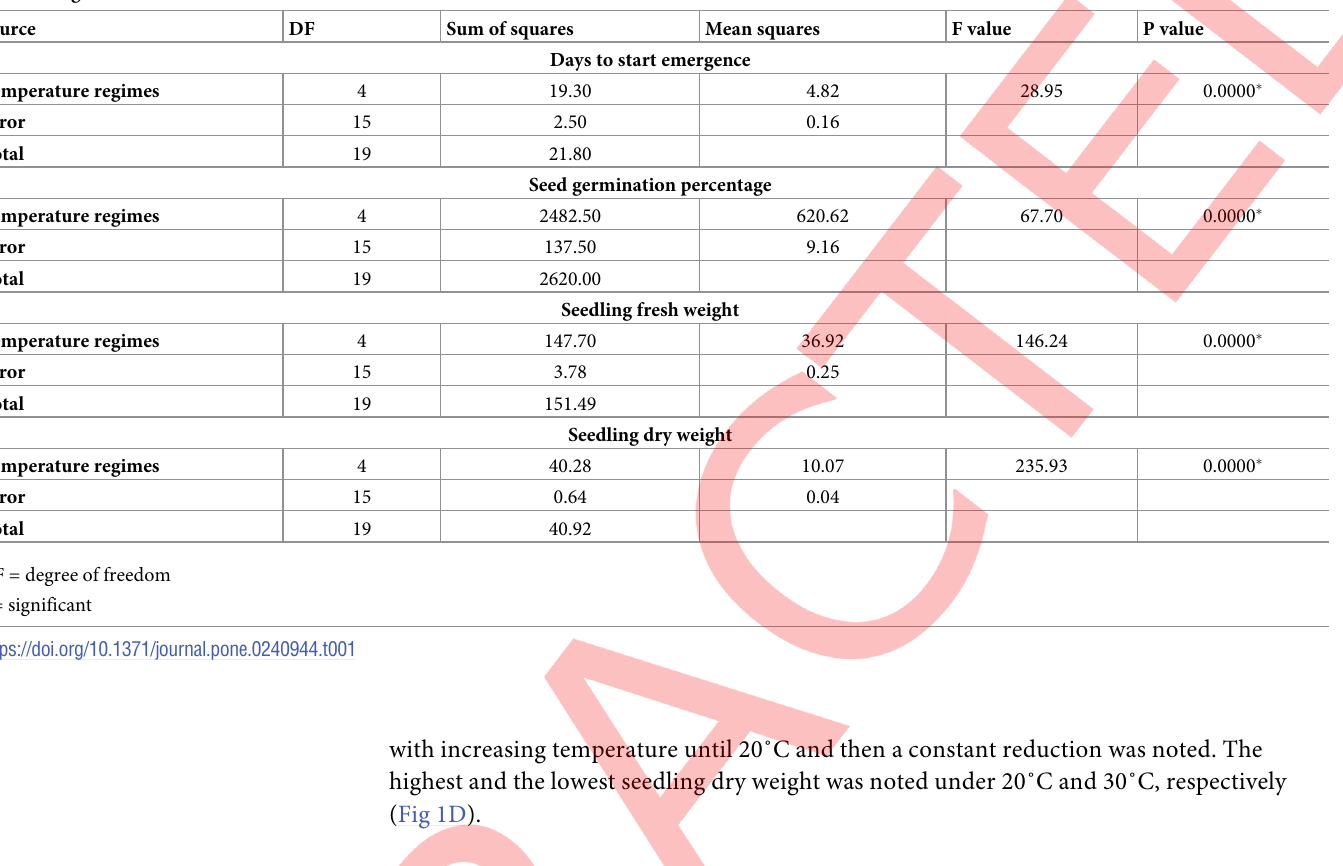
Experiment 2: Effect of seed burial depths on seedling emergence of wild